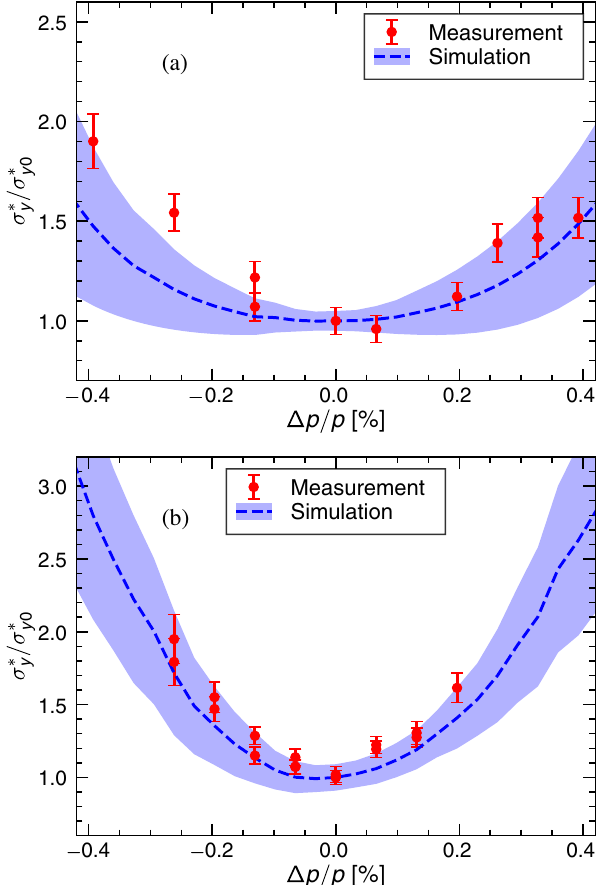
FIG. 10. The measured and simulated vertical momentum bandwidths for the 10 β (cid:1) x 1 β (cid:1) y (a) and ultralow β (cid:1) (b) optics. The beam sizes measured by the IPBSM have been converted to single-shot beam sizes with respect to the systemtatic errors